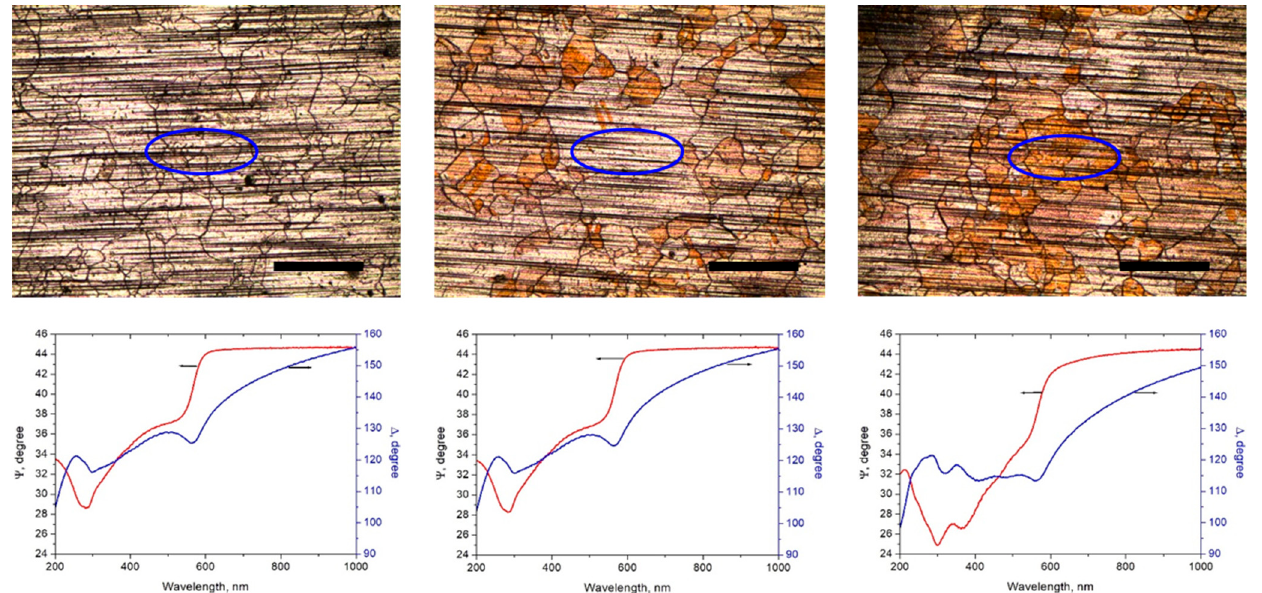
Figure 5. Top: Images of the SE-examined regions: “fresh” sample (left), low-oxidation region (middle) and high-oxidation region (right) of sample “6 months”. The scale bars represent 500 μ m. Bottom: corresponding Ψ - and Δ –spectra acquired from the ellipse-shaped regions shown in the images (angle of incidence 60°).